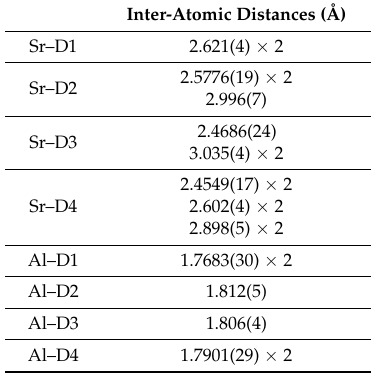
Table 2. Inter-atomic distances of SrAlD 5 . Estimated standard deviations are in